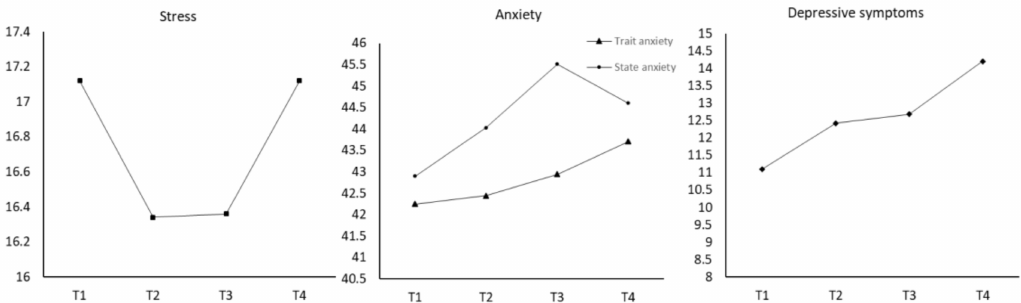
Figure 1. Longitudinal Changes of Perinatal Stress, Anxiety, and Depressive